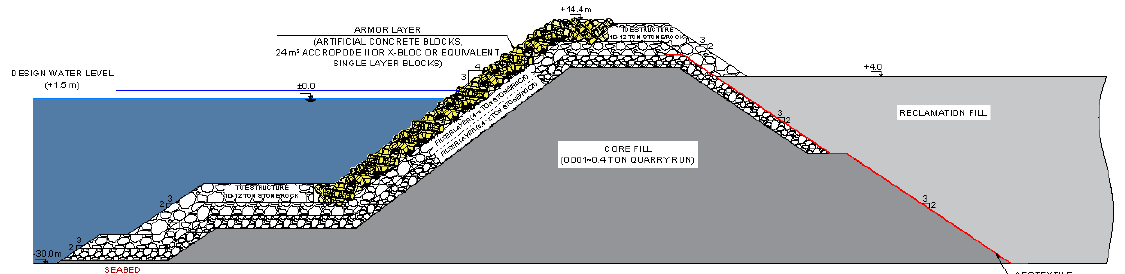
Figure 2. Conceptual cross-section design of alternative No. 3—5 km offshore − 30 m water depth [33].